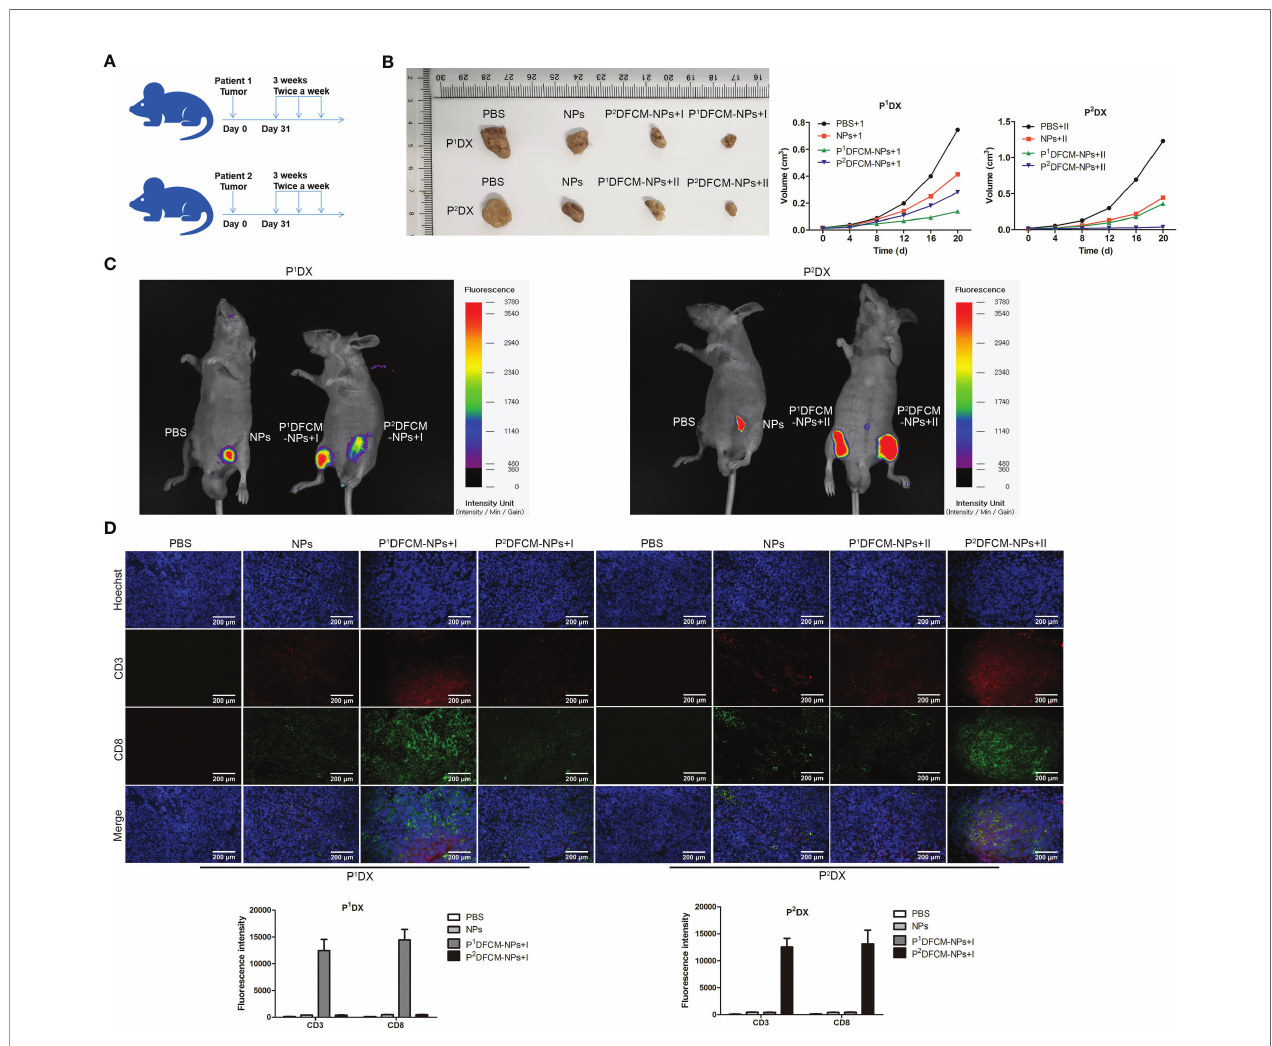
FIGURE 6 | Immune stimulation and therapeutic effect of FCM-NPs on PDX tumor model. (A) Schematic diagram of modeling and treatment of PDX tumor in mice. (B) The size changes of P 1 DX and P 2 DX tumor in PBS, NPs, CCM-NPs, DCM-NPs and FCM-NPs groups. (C) In vivo fl uorescence detection of the vaccine selectivity in double tumor mode. Scale bar = 200 m m. (D) Immuno fl uorescence staining of CD3 and CD8 in P 1 DX and P 2 DX tumor